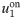
Rounds on target for input1 (= u1on, u1off, u1r) over 40 rounds on fine parameter grid with 66,086 grid points.With u0on∈{-1,…,1}, u0off∈{-2,…,2}, and u0r∈{-1,0,1}.